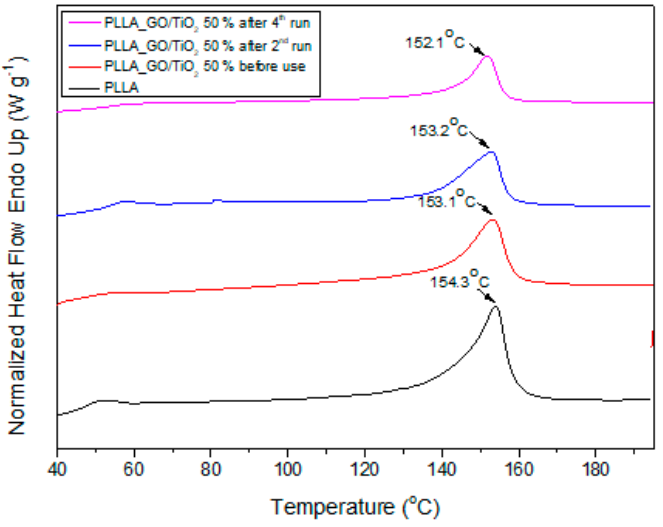
Figure 10. DSC thermograms of PLLA-GO/TiO 2 50 wt% films before and after different photocatalytic runs.